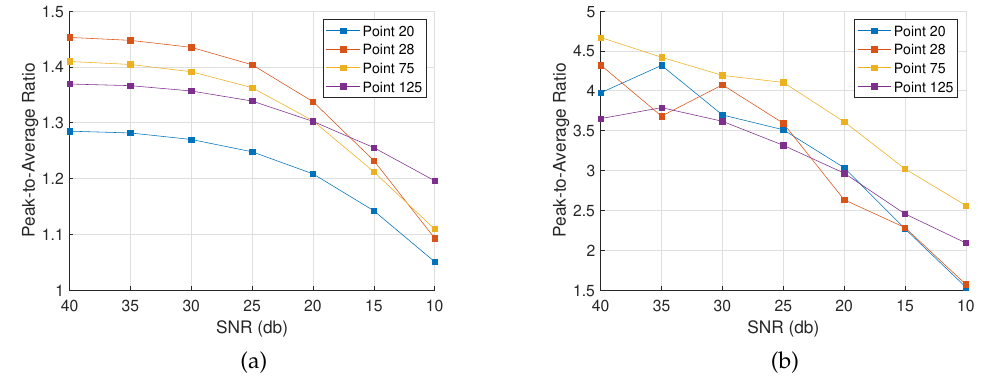
Figure 11. Peak-to-Average Ratio for damage configuration M 4 with varying SNR. ( a ) Complex Group Lasso. ( b ) Adaptive Complex Group Lasso.